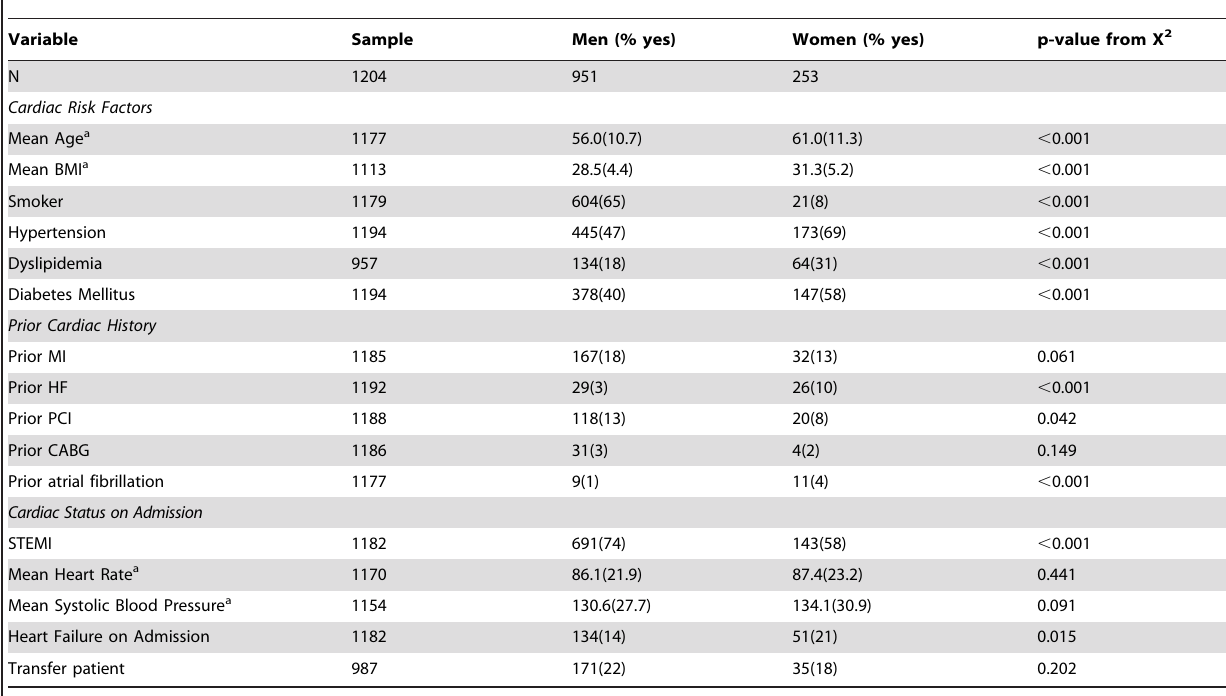
Table 1. Gender differences in initial